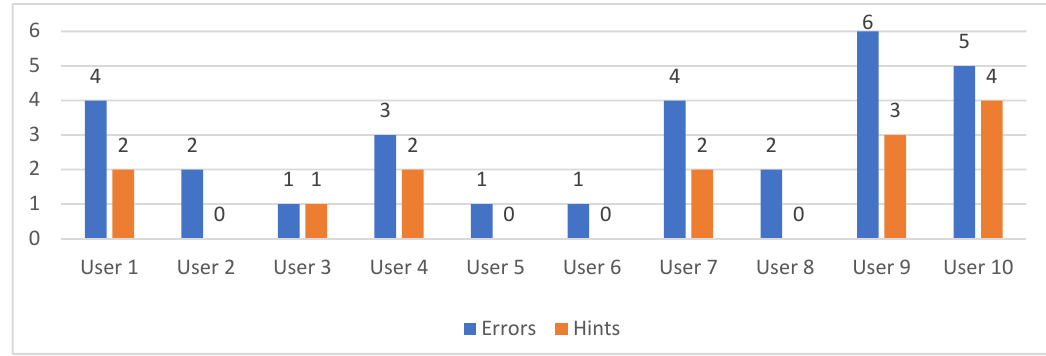
Figure 13. Errors and hints distribution per user.